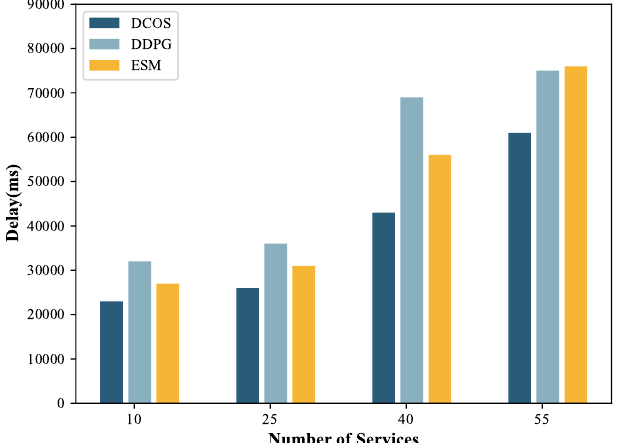
Figure 7. Comparison of delays in different service numbers.